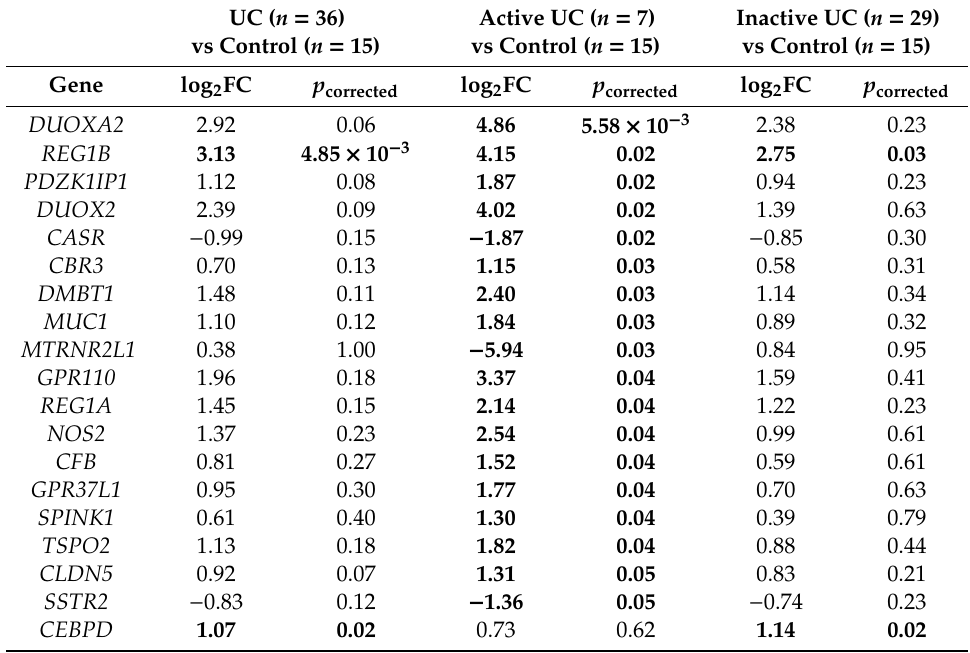
Table 2. Significantly differentially expressed genes in the terminal ileum of UC patients.